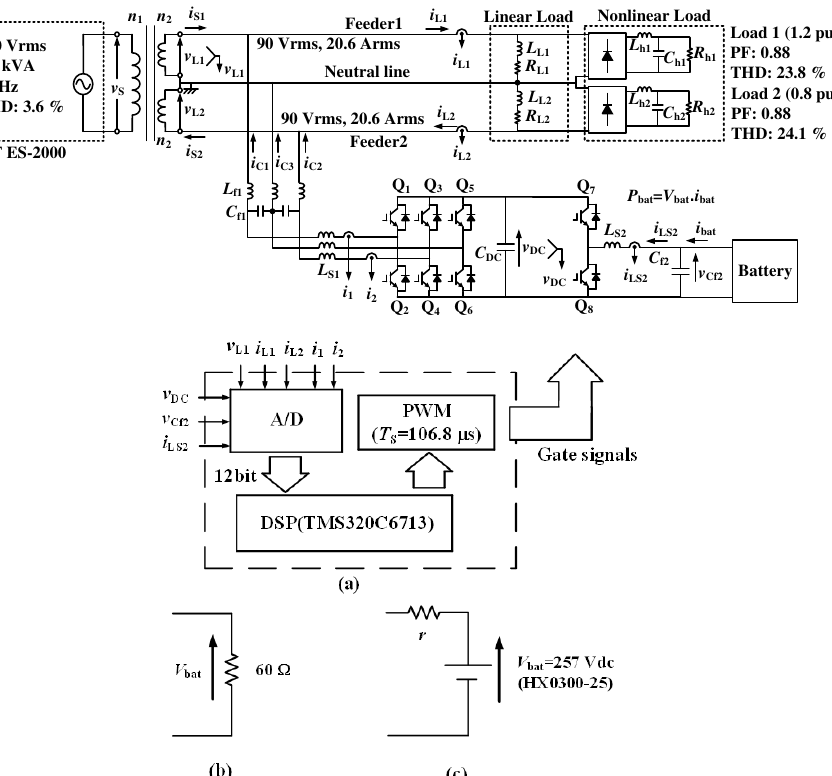
Figure 5. Block diagram of constructed experimental setup for BBC in Figure 1. ( a ) Power circuit and control block diagrams. ( b ) Battery model during battery-charging operation. ( c ) Battery model during battery-discharging